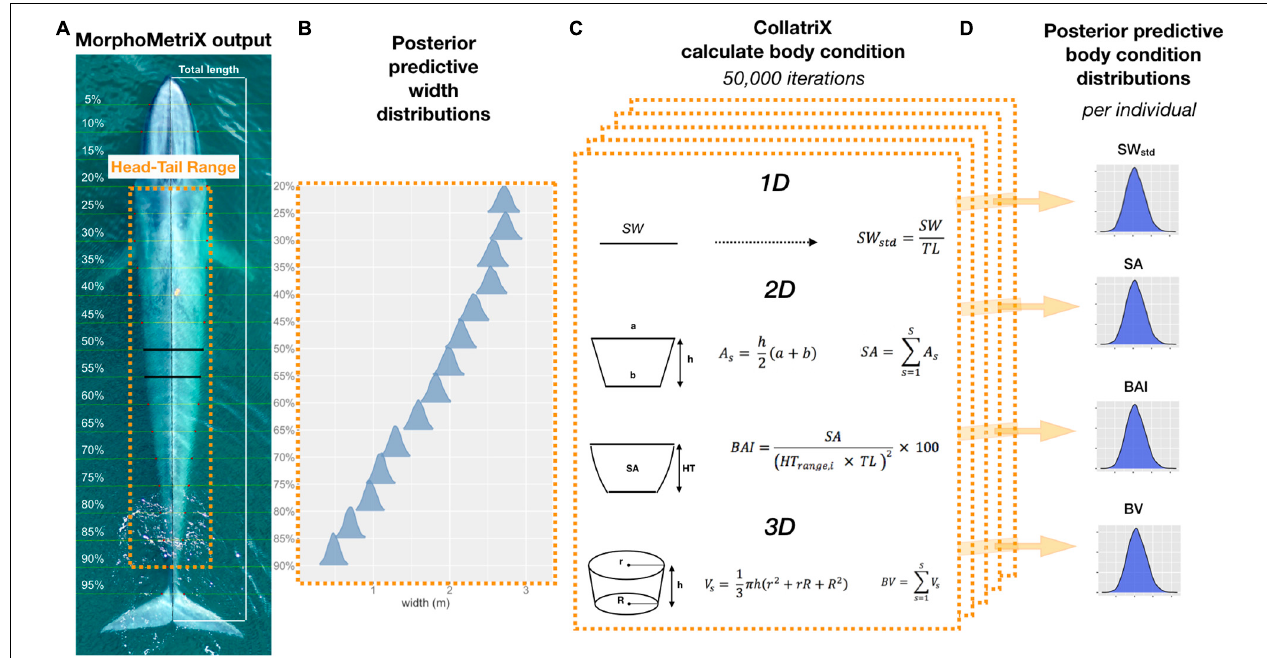
FIGURE 1 | Overview of Bayesian framework for calculating the different body condition metrics in this study. (A) An example of a MorphoMetriX output (Torres and Bierlich, 2020) from a UAS image of a blue whale. Total length (TL) measured from rostrum to fluke notch with perpendicular widths segmented in 5% increments of TL. Head-Tail Range represents the region of the body that excludes the fins, head, and tail that will be used to calculate each body condition metric. (B) Posterior predictive distributions for each 5% width included in the Head-Tail Range (20–90%) that will be used to calculate each body condition metric. (C) One-dimensional (1D), 2D, and 3D body condition metrics are calculated using CollatriX (Bird and Bierlich, 2020) for each iteration in the MCMC output of the posterior predicted widths. (D) The posterior predictive distributions for each body condition metric calculated for a single individual. SW std , standardized single width; SA, surface area; BAI, body area index; and BV, body